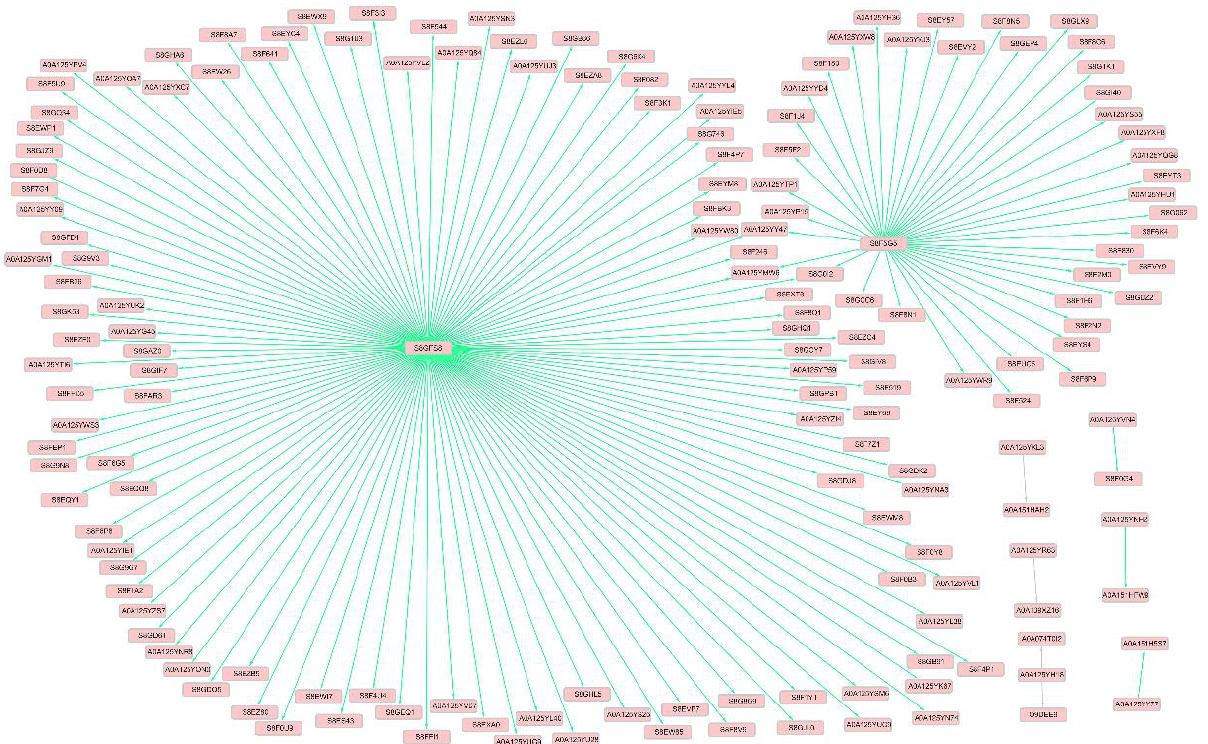
Figure 10. Network of kinase-phosphopeptide partners and potential phosphor- reliant interactions determined by correlation analysis. Light red nodes denoted phosphoproteins and edges represented interactors between phosphoproteins. The gray arrow denotes protein interactions which are presumed to be activated by the phosphorylation and green arrows represents protein interactions that are presumed to be inactivated by the phosphorylation.2.8. Potential Phosphor-Dependent In- teractions.